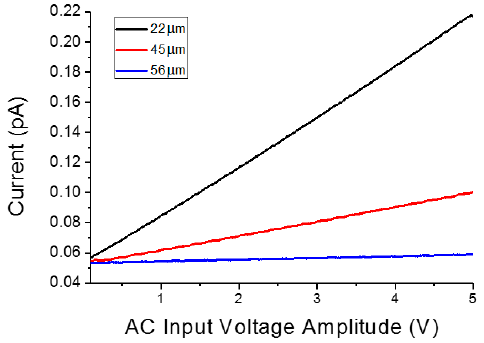
Figure 8. Current–voltage curves with one tip over a microparticle and the second tip at different distances. As expected, the impedance increased with the distance between the tips, and as the tips contacted the same microparticle (a distance of 22 µ m), two microparticles in contact with each other, (a distance of 45 µ m) and two microparticles not in contact with each other (a distance 56 of µ m).